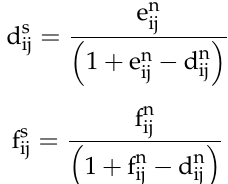
3. Total normalized crisp values are computed with the following Equation